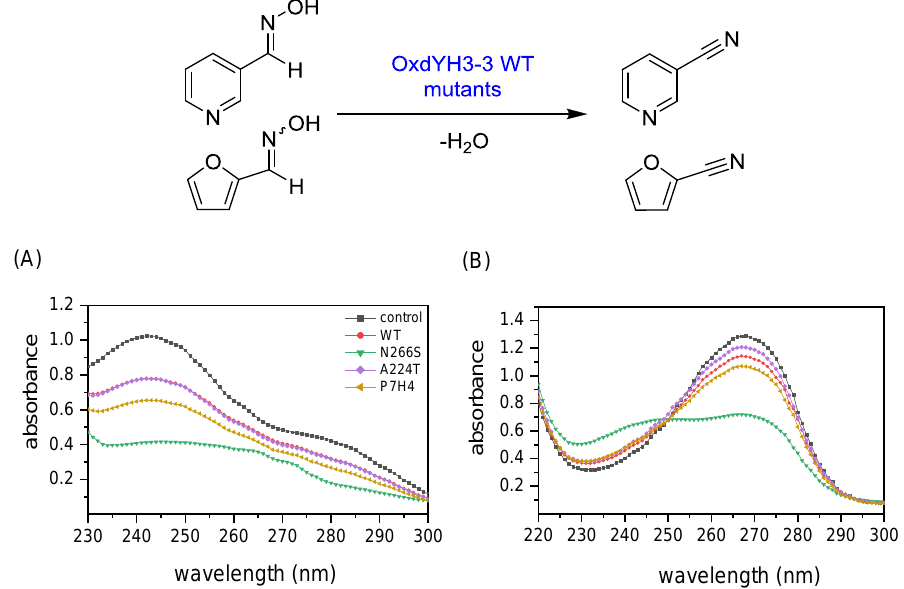
Figure 4. Absorbance scans of reaction solutions after 1 h of reaction time for reactions being performed at a substrate concentration of 50 mM of E -3-pyridine aldoxime ( A ) and 2-furfuryl aldoxime ( B ). Experiments with solutions of the substrates without biocatalysts were carried out as control experiments.